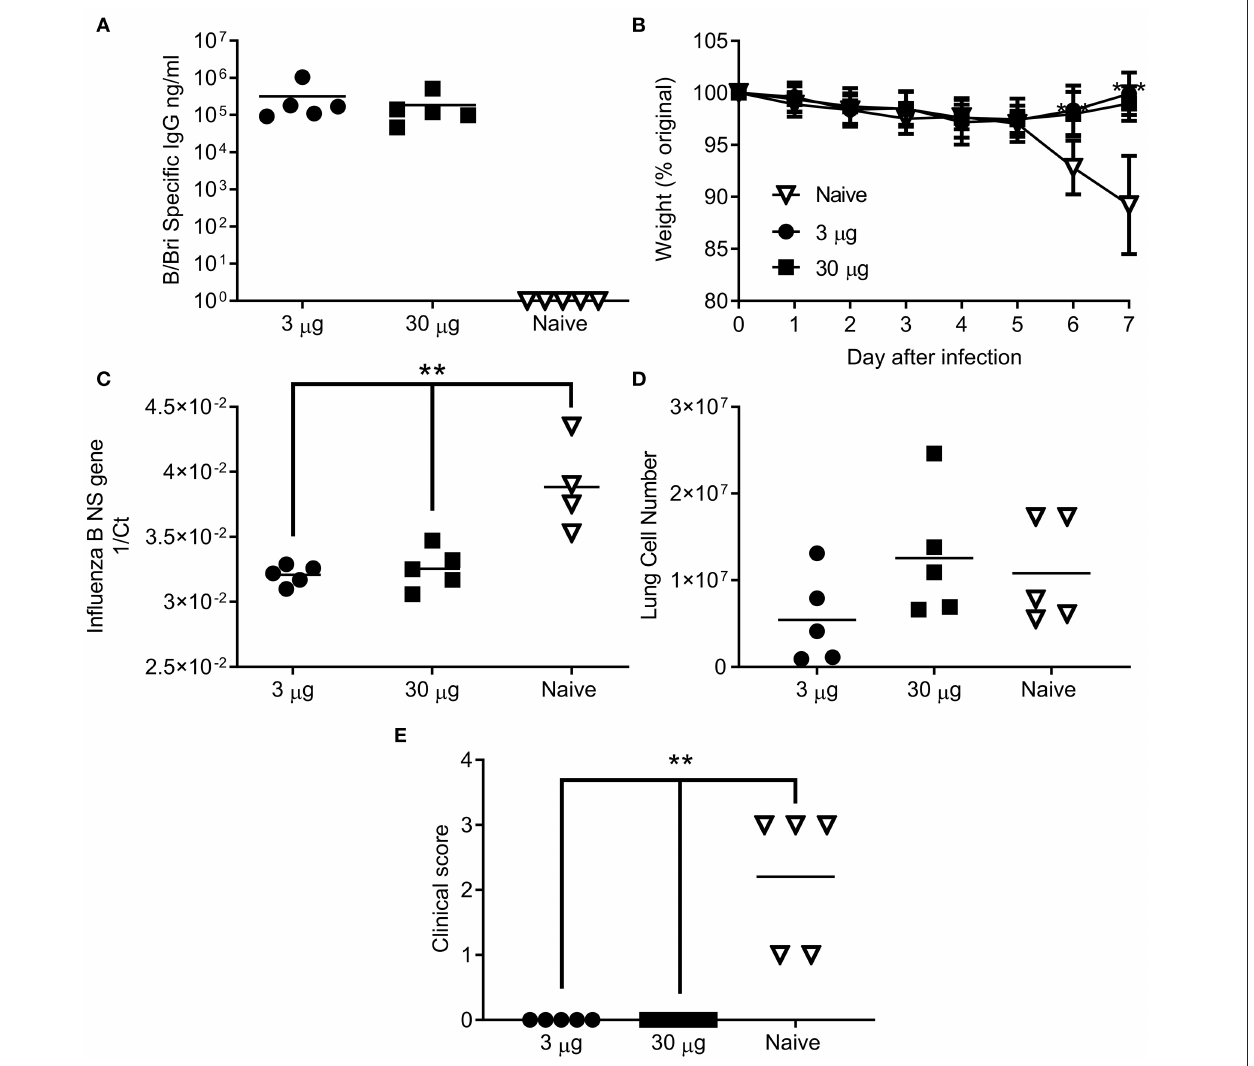
FIGURE 5 | Ciliate produced rHA protects against infection with B/Brisbane influenza. Mice were immunized three times at 3 weekly intervals with 30 or 3 µ g ciliate derived B/Bri by the intramuscular (i.m.) route. Two weeks after the final immunization, anti-B/Bri antibody titer was measured by ELISA (A) . Mice were then challenged with B/Bri by the intranasal route. Weight change (B) , viral load (C) , lung cell number (D) , and clinical score (E) were assessed after infection. Points represent individual animals (A,C,D,E) or mean (B) of n = 5 mice per group, ** p < 0.01, *** p < 0.001 by ANOVA and post test.